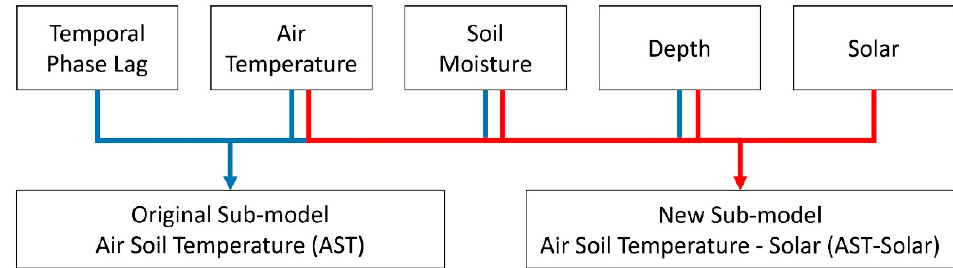
Figure 3. Combined AST and AST-Solar subroutines’ schematic depicts the input data driving both models and displays the crucial data input difference between AST and AST-Solar with Temporal Phase Lag influencing only AST and Solar Energy influencing only AST-Solar.